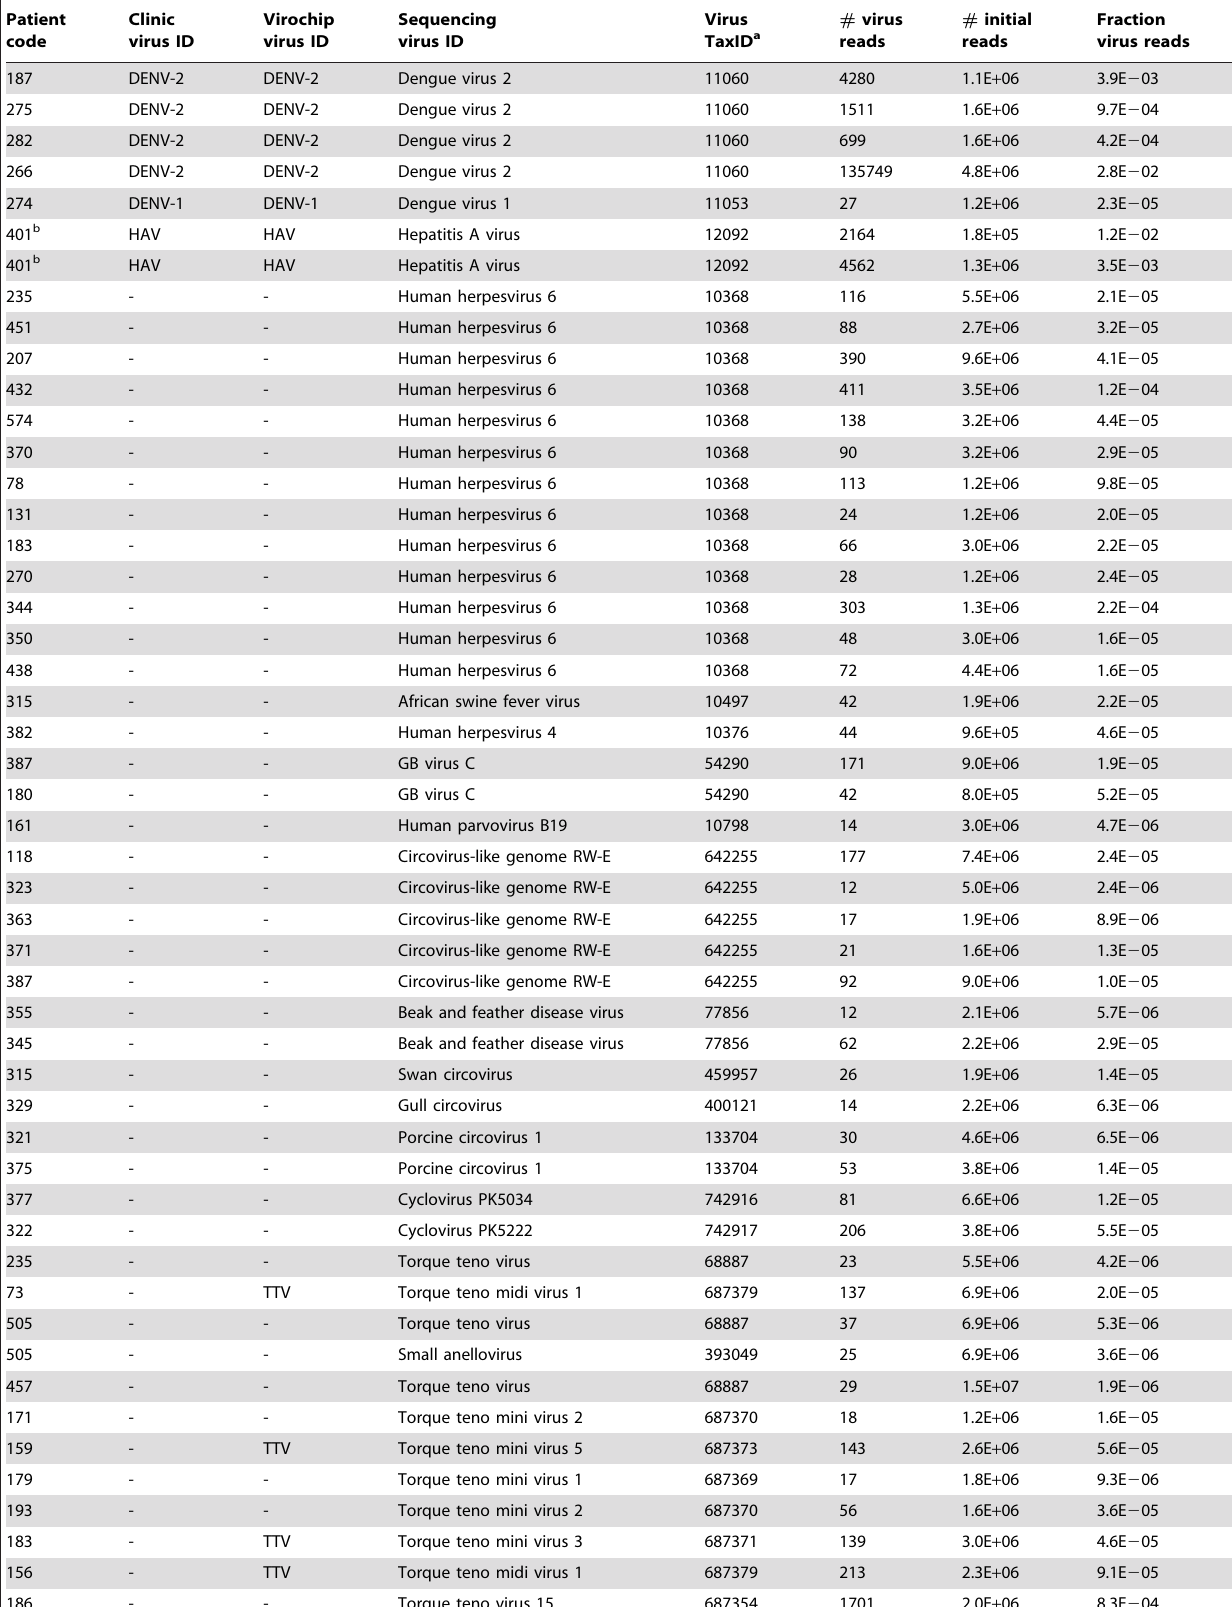
Table 1. Summary of viruses identified in this